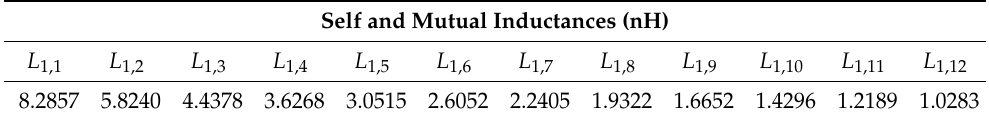
Table 1. Self and mutual inductance of the first bond